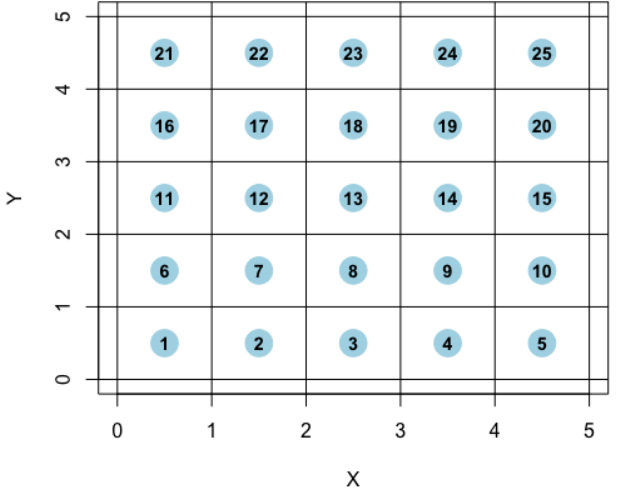
Figure 5. Discretization of a random field with 5 × 5 grid points.